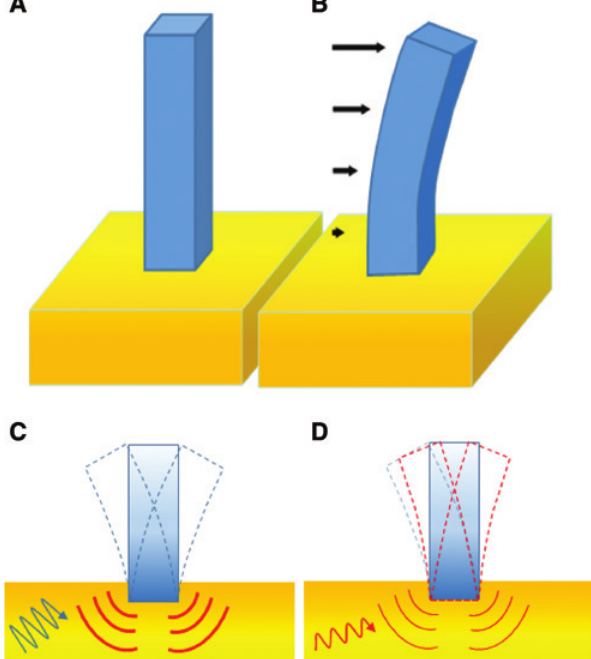
Figure 4: Deformation of building on a thick plate versus building under seismic disturbance: (A) Building at rest. (B) Elastic deformation for the first fundamental mode of the building. (C) Building under seismic disturbance and inertial interaction represented as a secondary seismic source, before the